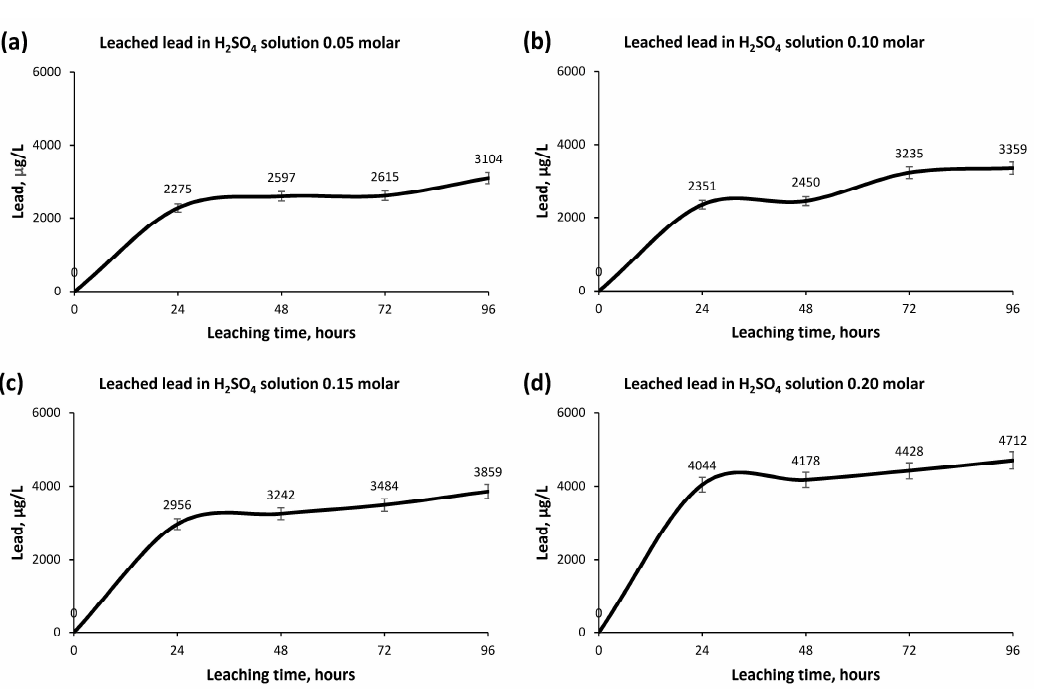
Figure 9. Analysis of the Nickel concentration in the leaching process at atmospheric pressure, ambient temperature and in different Sulphuric Acid solutions: ( a ) 0.05 molar H 2 SO 4 solution, ( b ) 0.10 molar H 2 SO 4 solution, ( c ) 0.15 molar H 2 SO 4 solution and ( d ) 0.20 molar H 2 SO 4 solution.